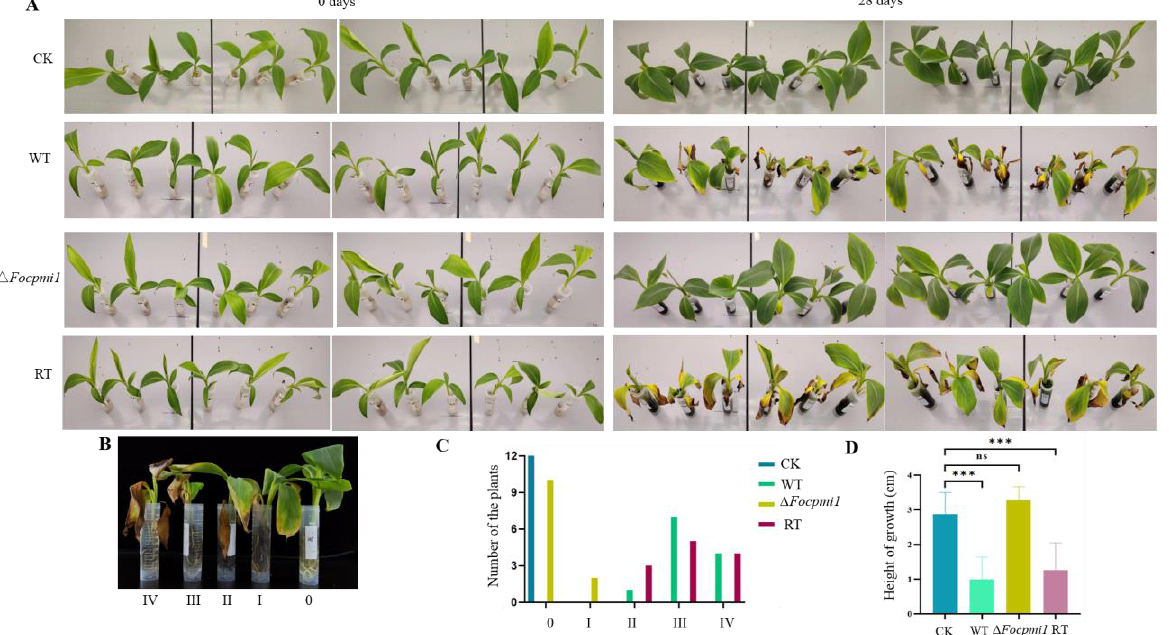
Figure 6. Leaf wilt symptoms from the susceptible banana plants infected by the indicated strains. ( A ) Banana plants inoculated with the WT, ∆ Focpmi1 , and RT strains and CK (no spores) were observed for 28 days to monitor the development of fusarium wilt syndrome. ( B ) The severity of leaf yellowing was graded from 0 (no symptoms) to IV (complete yellowing). ( C ) The number of plants developing leaf disease severity was recorded for each infected group. ( D ) Height of banana plants infected by indicated strains. The data represents the mean ± SD from three independent experiments. Asterisks indicate significant differences (Student’s t -test, *** p < 0.001). Similarly, the severity of rhizome disease was classified into five grades, with grade